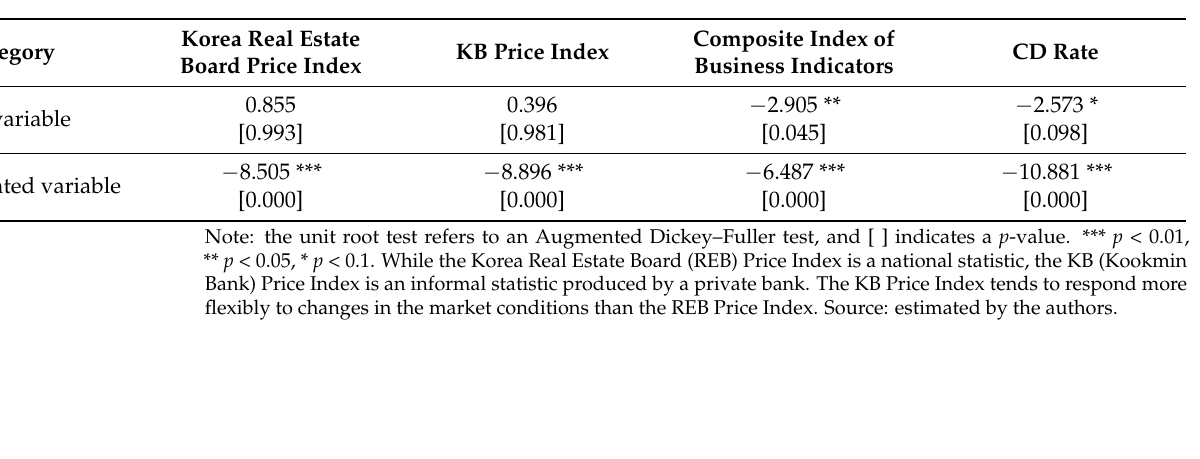
Table 1. Unit Root Test